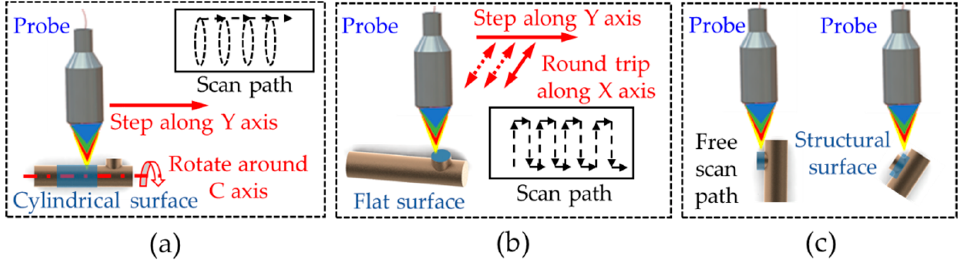
Figure 3. Schematic diagrams for different measurement paths: ( a ) rotary scanning paths; ( b ) raster paths; ( c ) free scanning paths.